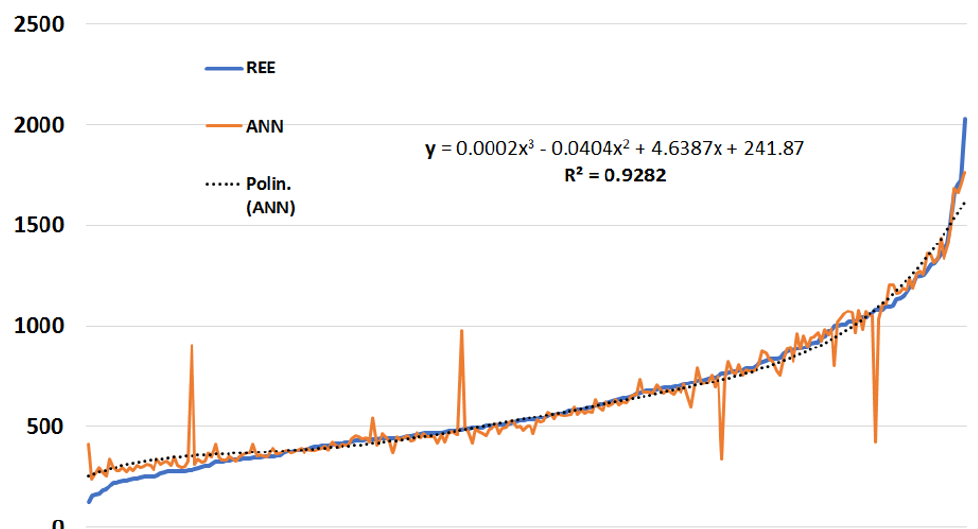
Figure 3. Real REE approximation with neural networks. Legend. Blue line expresses the true REE values; orange line represents the corresponding fitting of the method under evaluation, and the dotted line is the tendency line described by a five-degree polynomial equation. REE = Resting Energy Expenditure; ANN = Artificial Neural Networks.